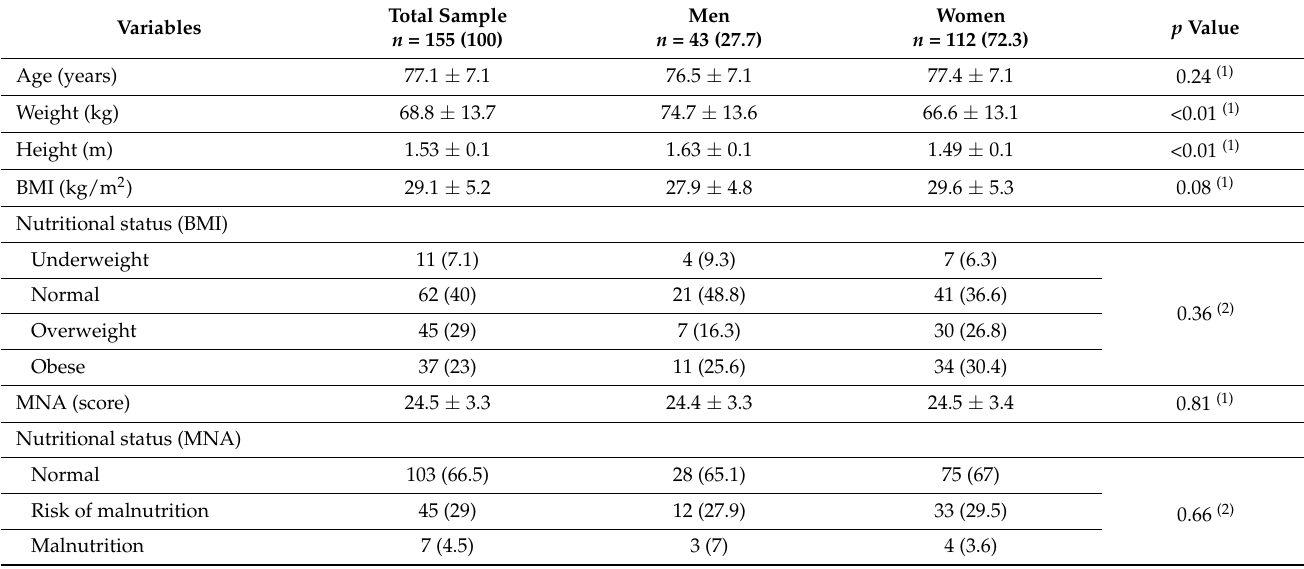
Table 1. Characteristics of the sample according to